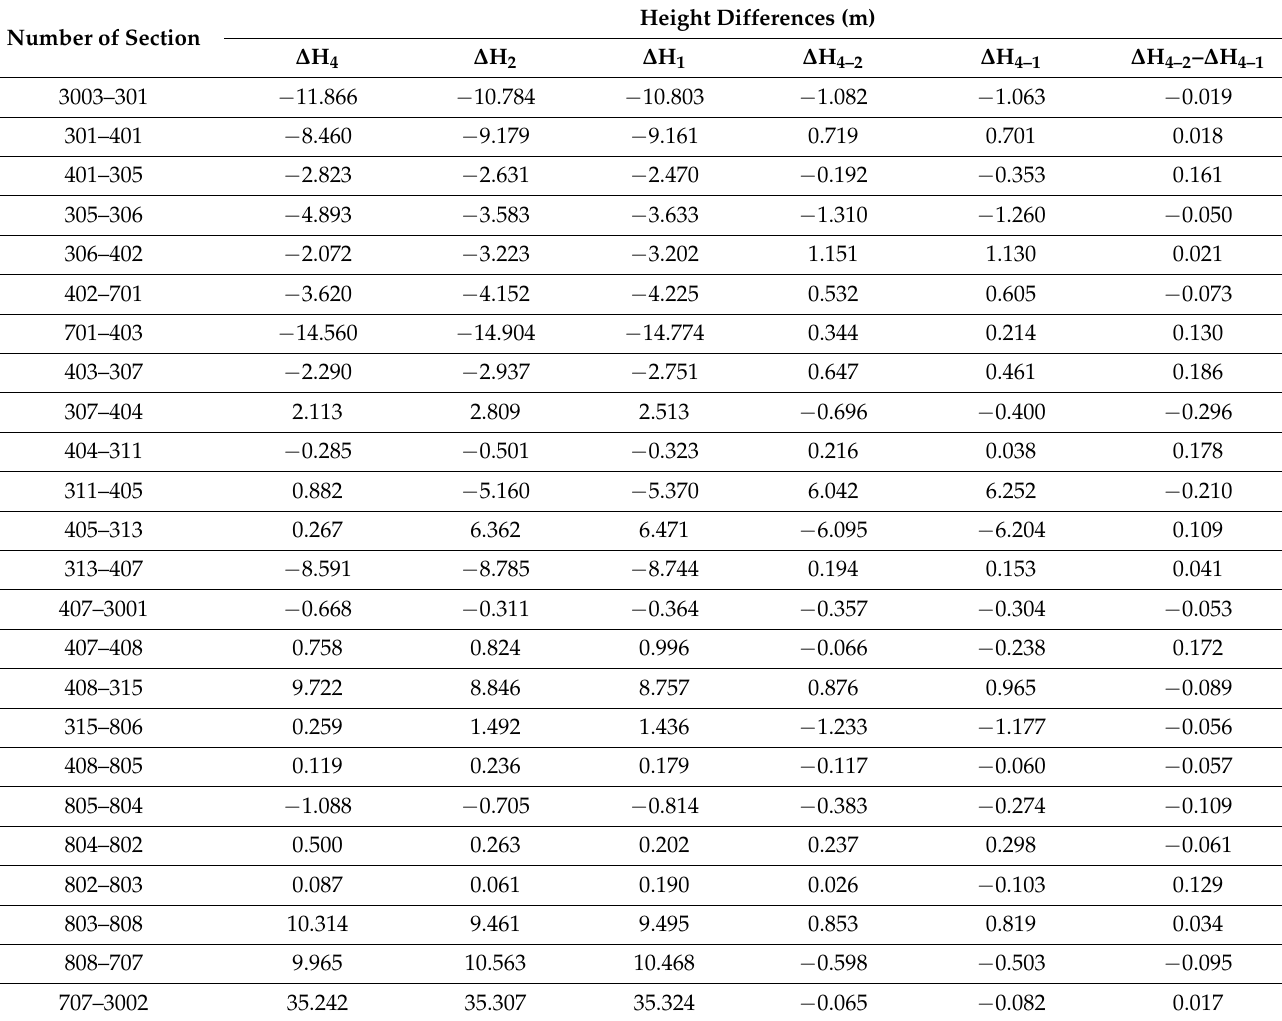
Table 2. Summary of elevation differences on selected sections between control points.